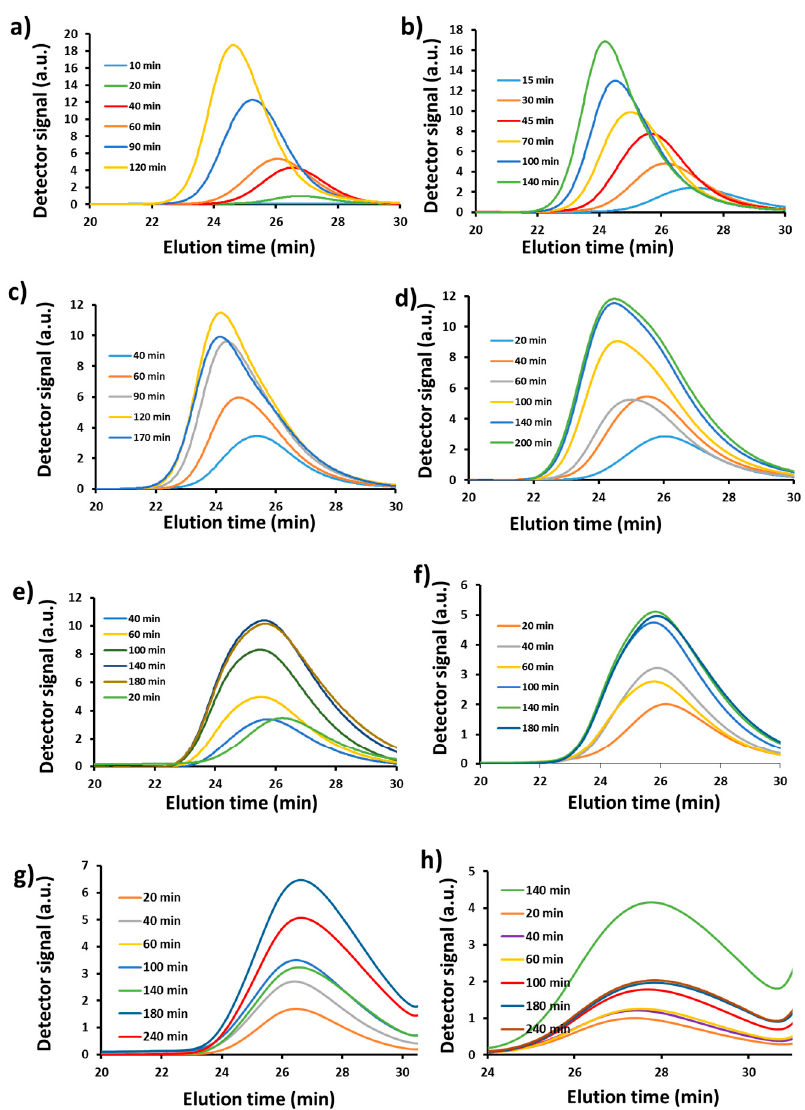
Figure 4. GPC traces (elution time) of DBI-S copolymerizations done at done at 110 °C.: ( a ) f DBI,0 = 0.1, ( b ) f DBI,0 = 0.2, ( c ) f DBI,0 = 0.3, ( d ) f DBI,0 = 0.4, ( e ) f DBI,0 = 0.5, ( f ) f DBI,0 = 0.6, ( g ) f DBI,0 = 0.7, ( h ) f DBI,0 = 0.8. Table 3. Summary of equimolar dibutyl itaconate/styrene copolymerizations in 50 wt% dioxane solution at various temperatures.